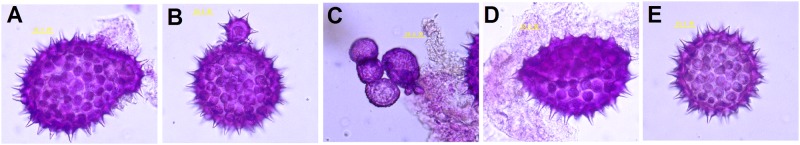
Various abnormal pollen grains after meiosis of Gossypium herbaceum × G. raimondii F1 hybrid.A) Big oval-shaped pollen. B) Small under-developed pollen. C) Deformed pollen. D) Cracked pollen. E) Normal pollen.